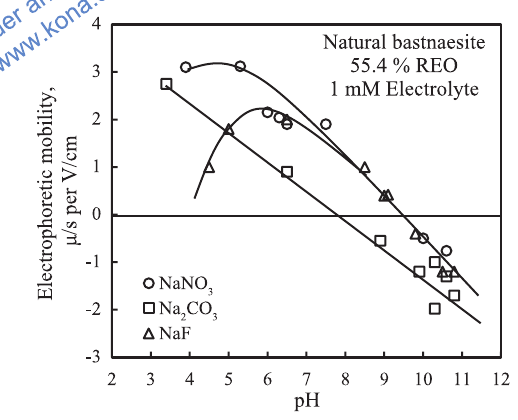
Fig. 6 Electrophoretic mobility of natural bastnaesite as a function of pH in the presence of 1 mM sodium nitrate, sodium carbonate and sodium